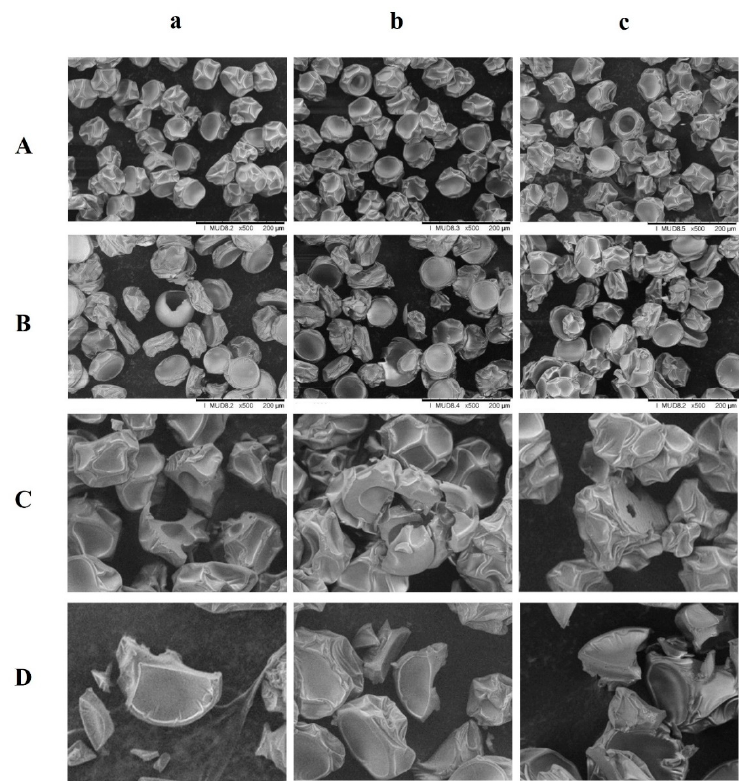
Figure 1. SEM micrograph of spray-dried C. paliurus extracts microencapsulated with (a) MD, (b) MD and GA at the ratio of 1:1, and (c) MD and GA at the ratio of 3:1. Rows ( A , B ) refers to the surface structure of powders containing aqueous and ethanol extract, respectively (500× magnification); rows ( C , D ) are the cross-section structure of the aqueous-extract and ethanol extract powders, respectively (800× magnification).